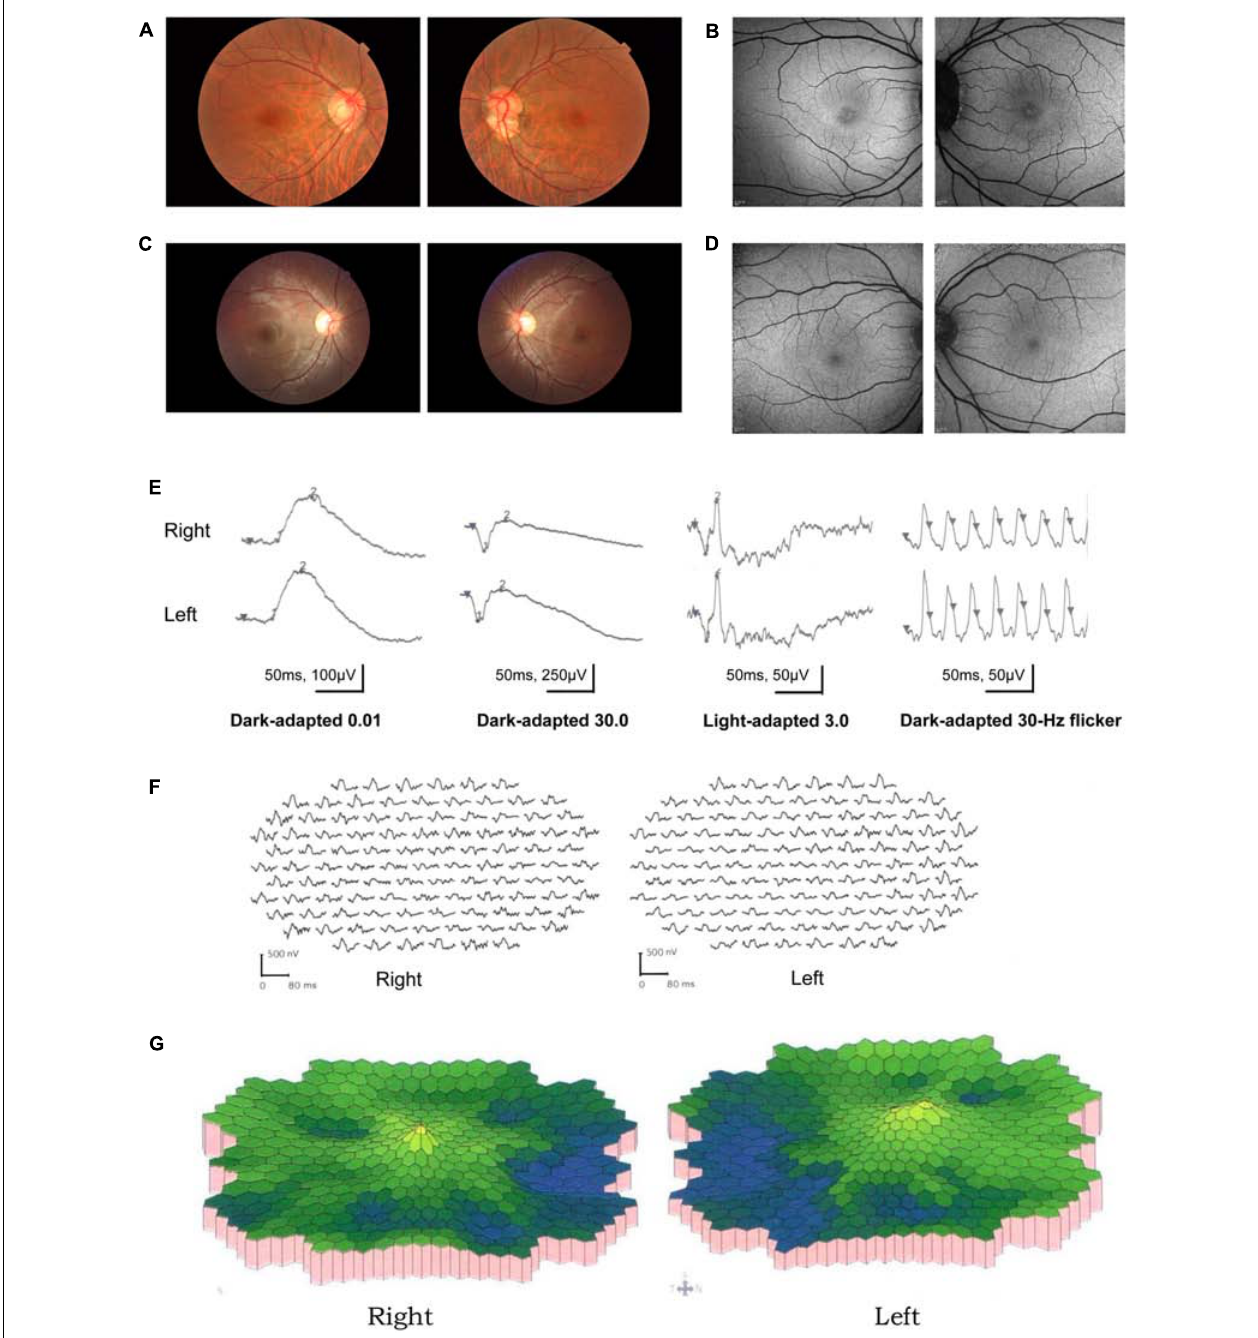
FIGURE 1 | Results of ocular examination of the proband (P5) and his son (P7). Photographs of the fundus (A,C) and fundus autofluorescence (C,D) of both eyes of the P5 (A,B) and P7 (C,D) . (E) (P5) Full-field rod, mixed rod-cone, and cone ERGs, and 30-Hz flicker responses. All the responses were normal in both eyes. (F,G) (P5). Amplitudes in the rings 1–3 of both eyes were significantly reduced, with the right eye more seriously